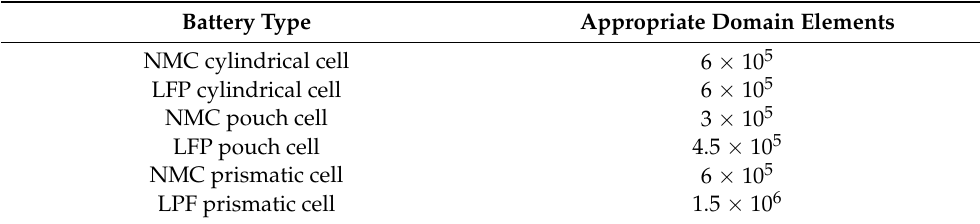
Table 2. Domain elements for simulation